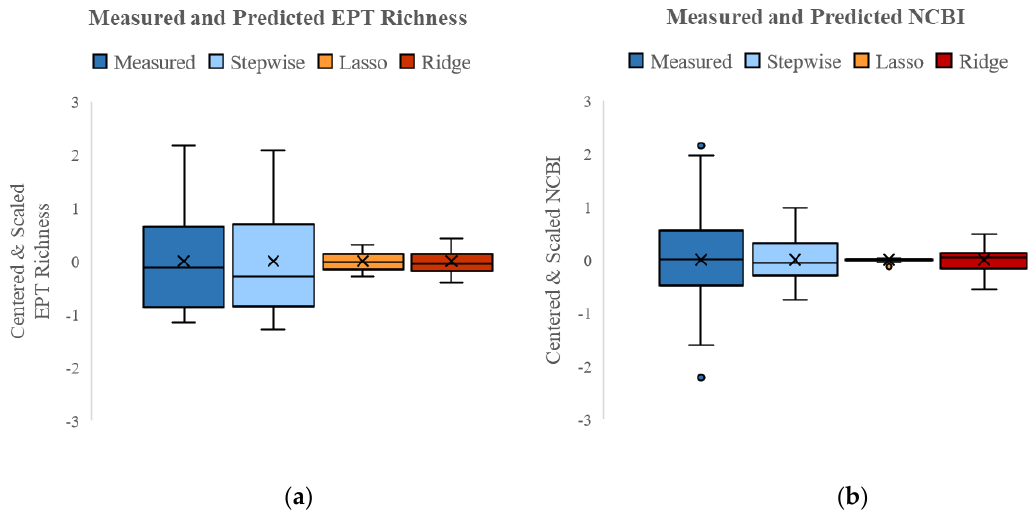
Figure 4. Measured and predicted centered and scaled values for ( a ) EPT richness and ( b ) the NCBI for the reduced SQT+ stepwise dataset (n = 34). The “x” indicates the mean value.